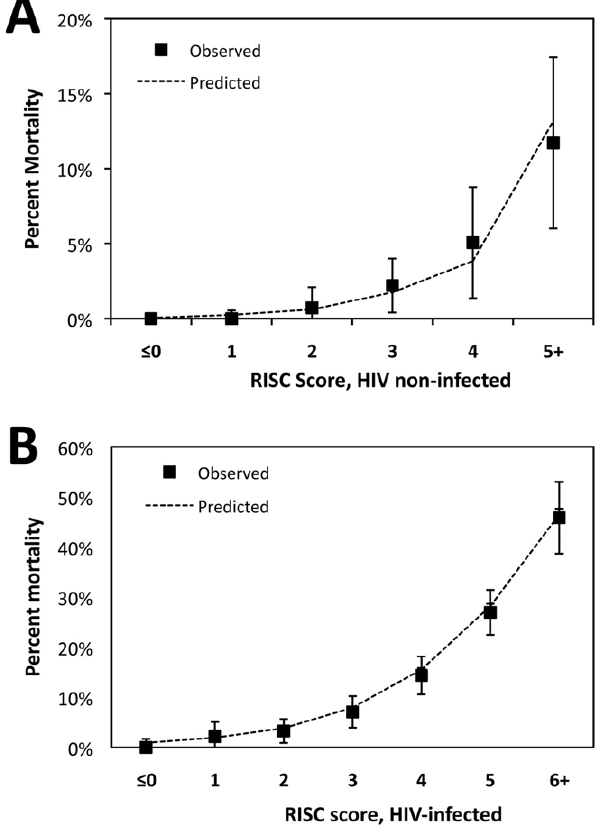
Figure 1. Observed mortality (with 95% confidence intervals) and mean predicted mortality by RISC score for children , 24 months hospitalized with LRTI, (A) without HIV infection and (B) with HIV